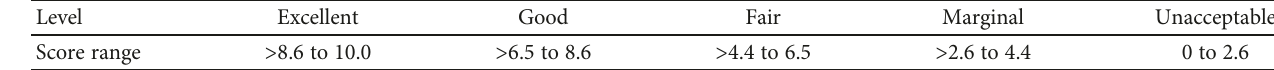
Table 4: ISO bio fi delity classi fi cations.